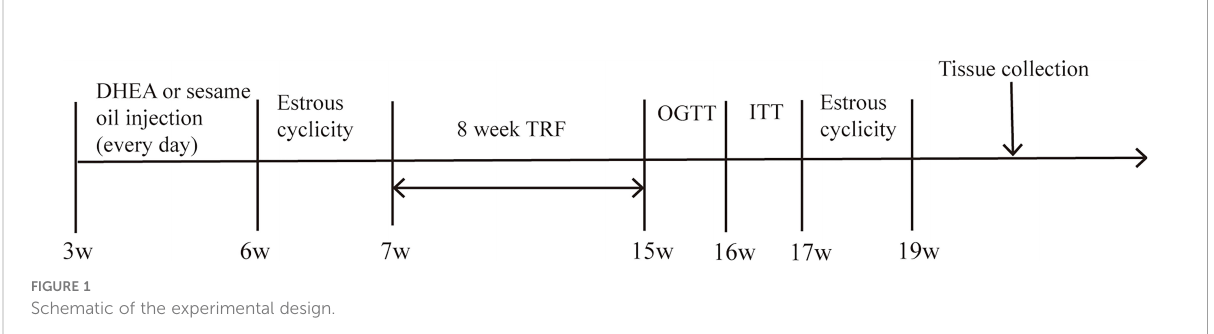
FIGURE 1 Schematic of the experimental